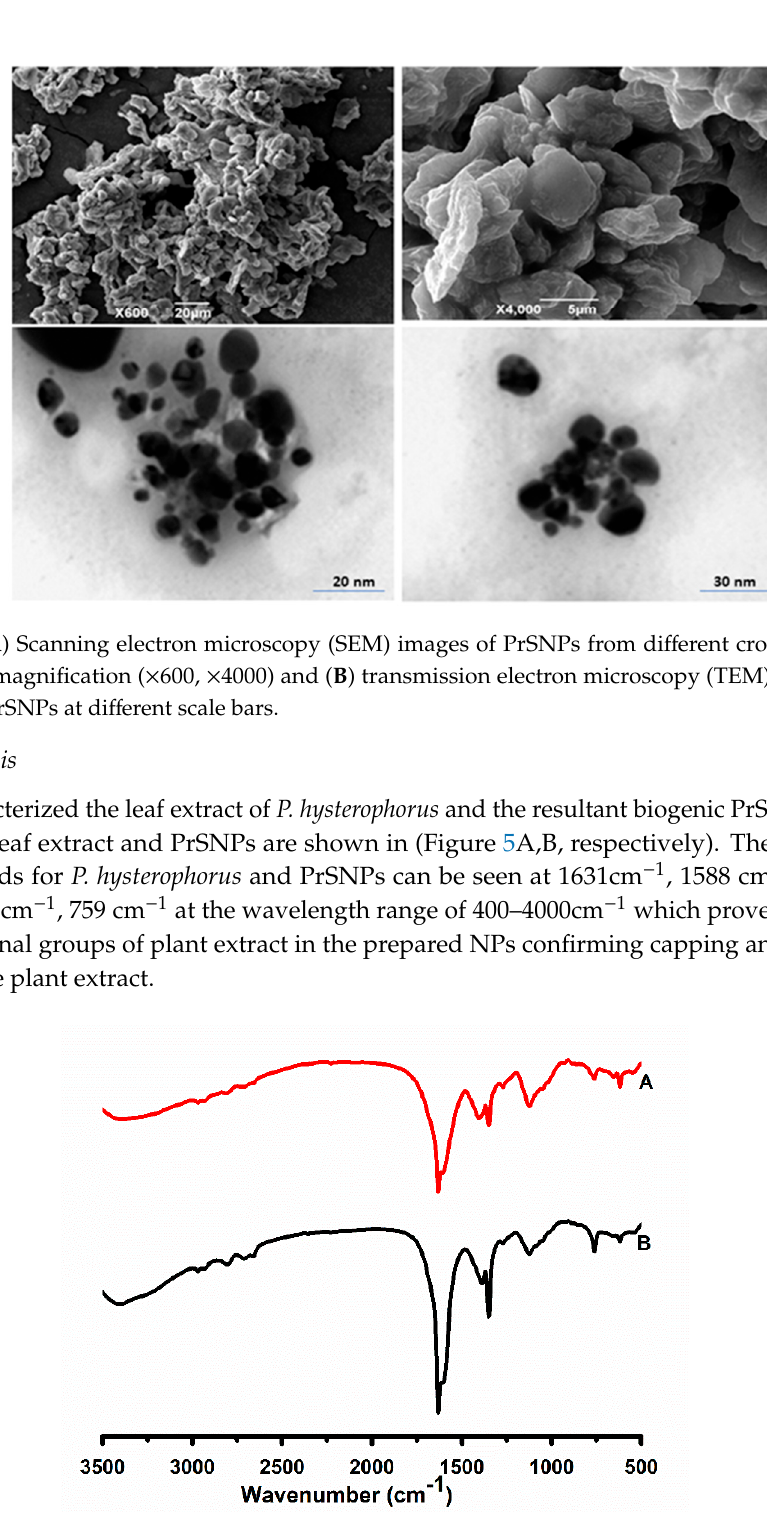
Figure 5. Fourier transform infrared (FTIR) spectra of P. hysterphorus leaf extract ( A ) and optimized PrSNPs ( B ).